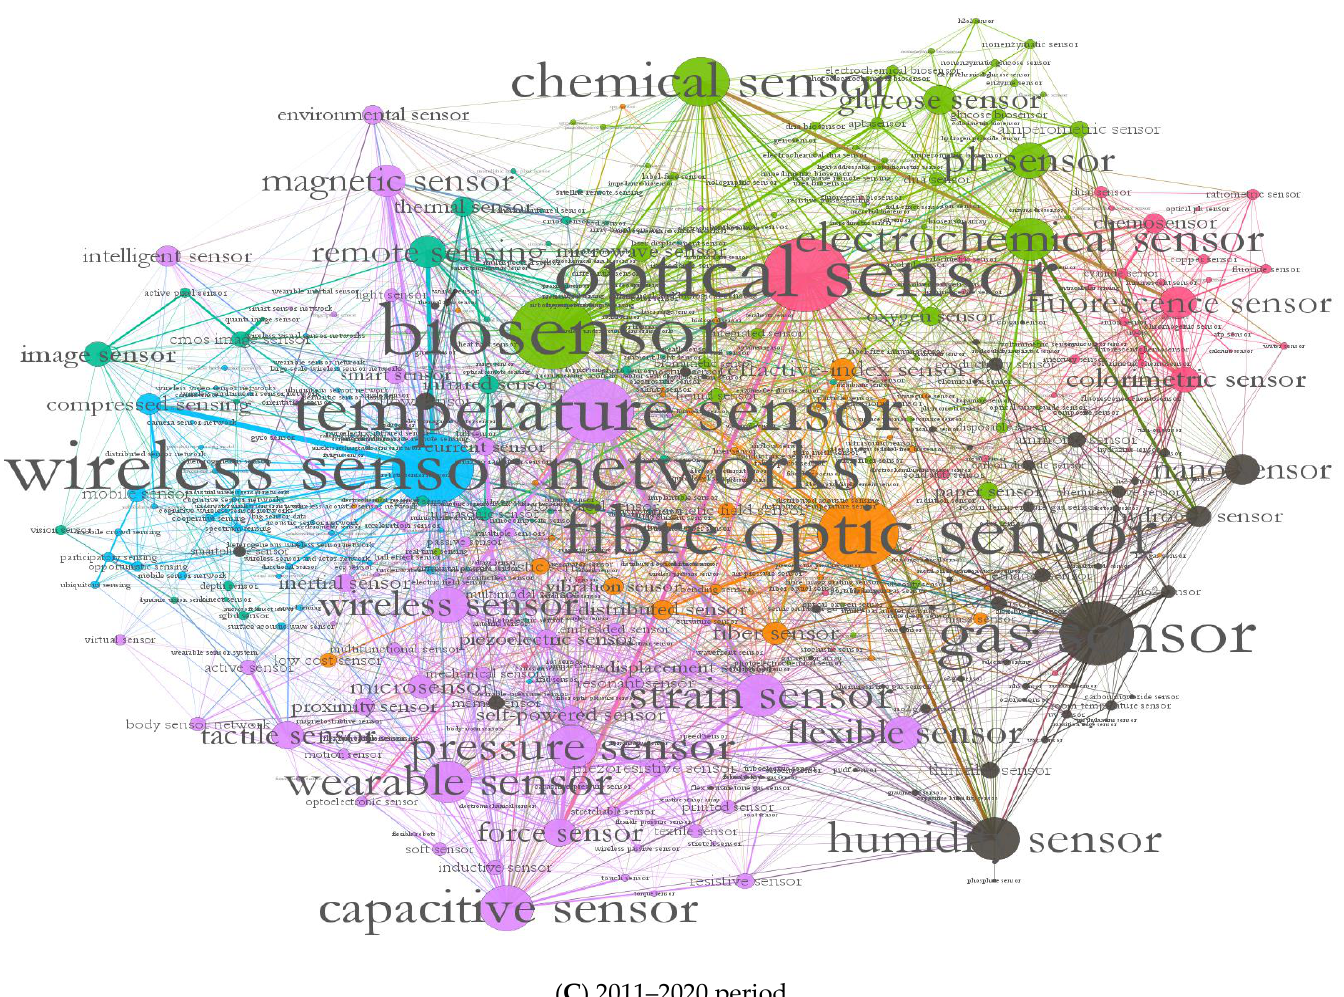
Figure 1. Structure and evolution of scientific and technological networks in sensors over time ( A ) from 1990 to 2000. ( B ) from 2001 to 2010. ( C ) from 2011 to 2020.